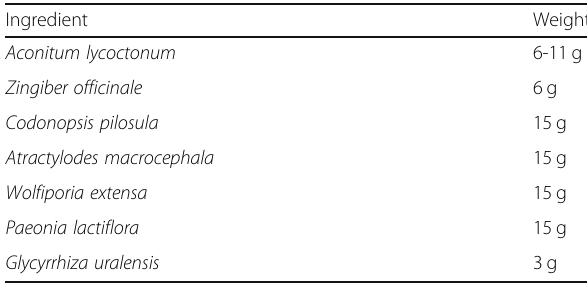
Table 1 The composition of WSJPR Ingredient